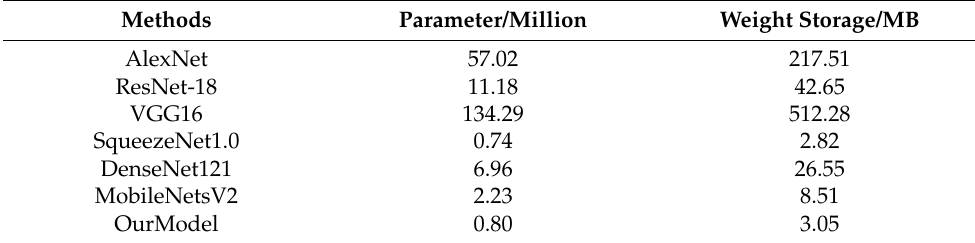
Table 4. Core module construction of